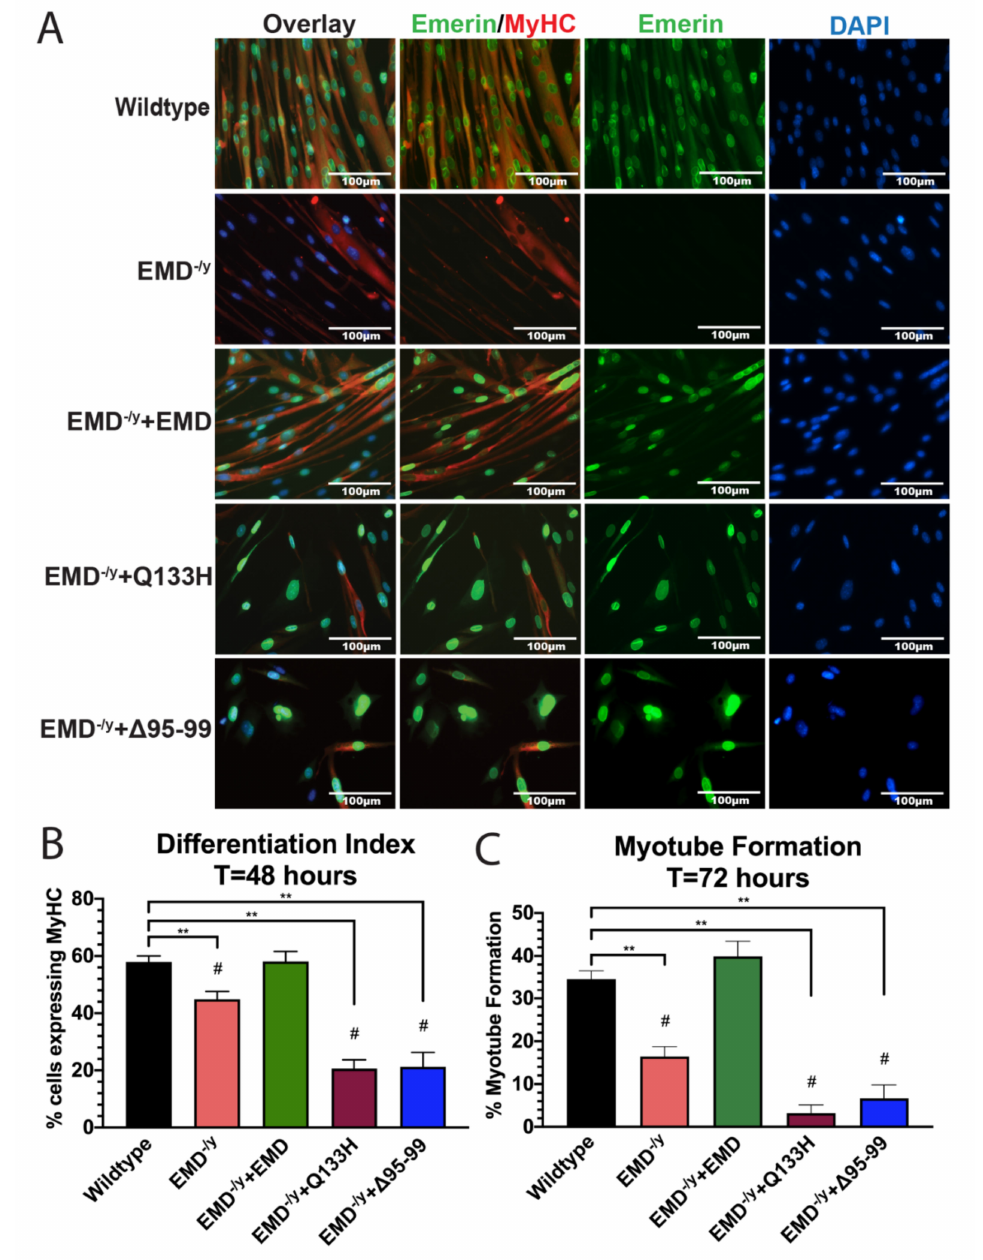
Figure 5. EDMD-causing emerin mutant myogenic progenitors Q133H and ∆ 95–99 display impaired myogenic di ff erentiation. ( A ) Immunofluorescence images at 72 h post di ff erentiation induction. Scale bar: 100 µ m. ( B ) The di ff erentiation index was calculated at 48 h after di ff erentiation induction. Both Q133H and ∆ 95–99 showed decreased MyHC expression compared to wildtype cells. ( C ) Myotube formation was assessed at 72 h after di ff erentiation induction. Both EDMD-causing emerin